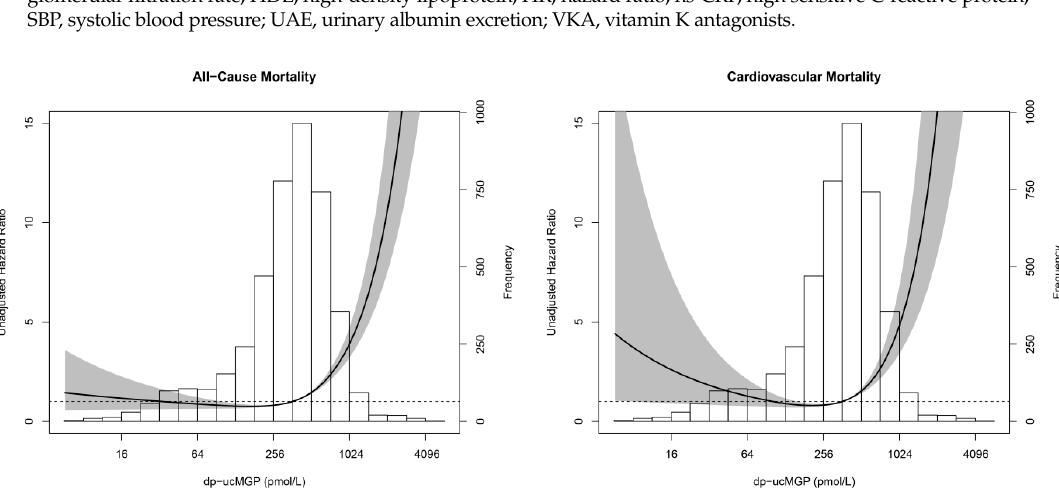
Figure 2. Restricted cubic spline depicting the J-shaped association of dp-ucMGP with all-cause and cardiovascular mortality. The line in the graph represents the risk for all-cause and cardiovascular mortality. The grey area represents the 95% CI of the HR.